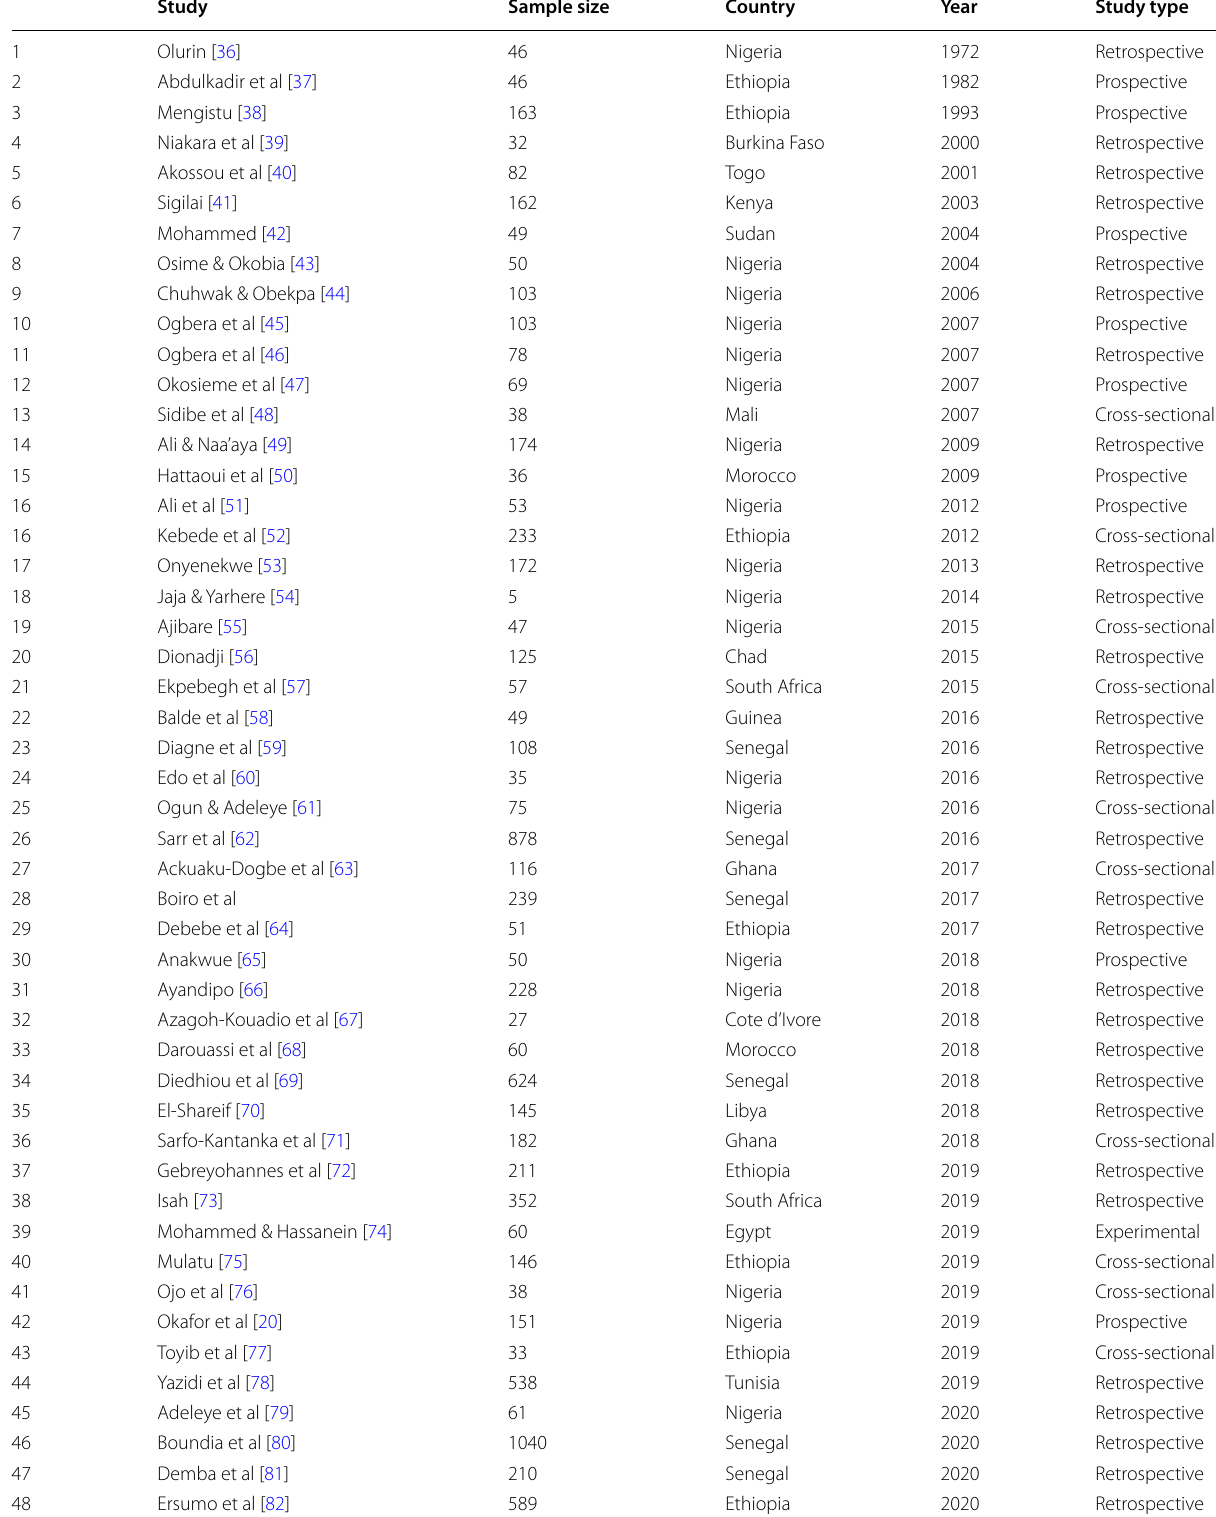
Table 3 Characteristics of the selected